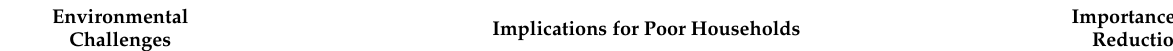
Table 4. Relationship between poverty and environment in